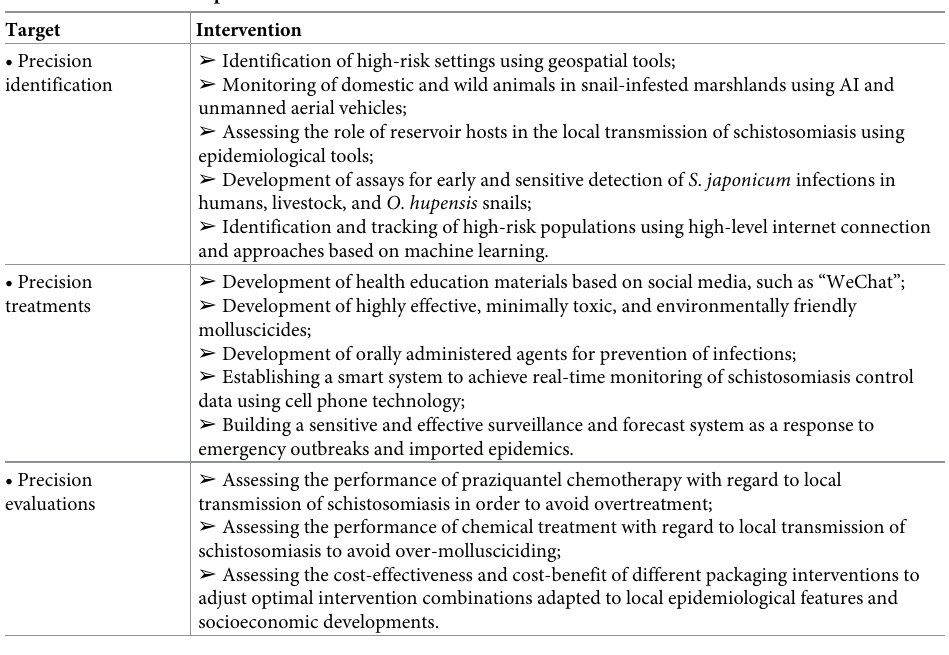
Table 3. Future research priorities for the elimination of schistosomiasis in